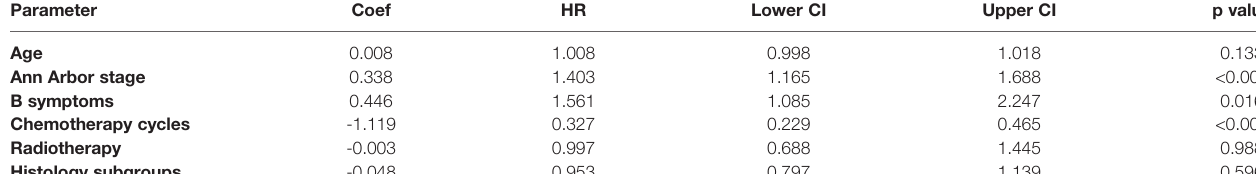
TABLE 3 | Multivariate analysis of all the patients. Parameter